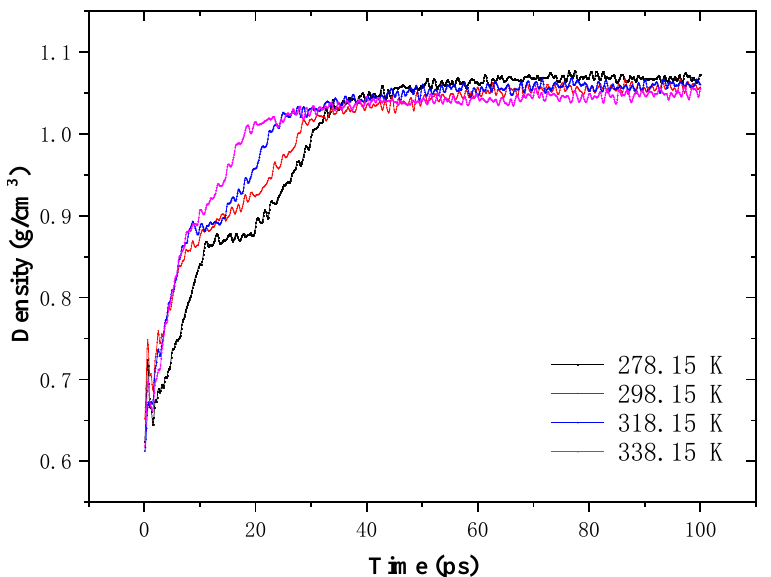
Figure 9. Density variation of the self-healing model of aged asphalt binder with 1 nm crack.